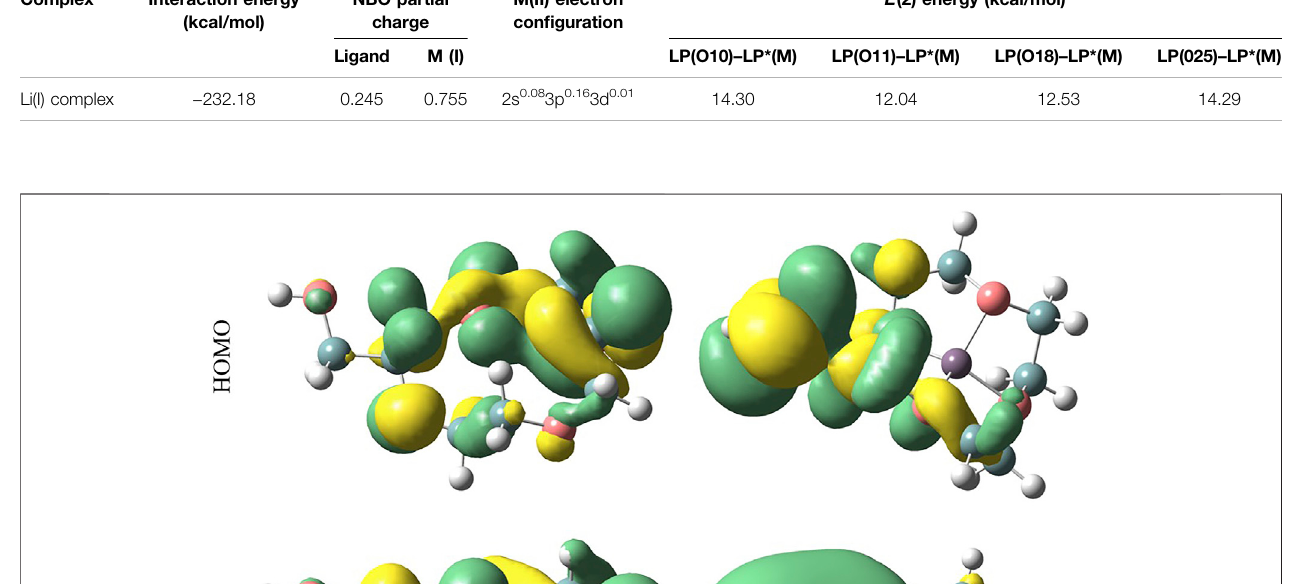
Frontiers in Energy Research |